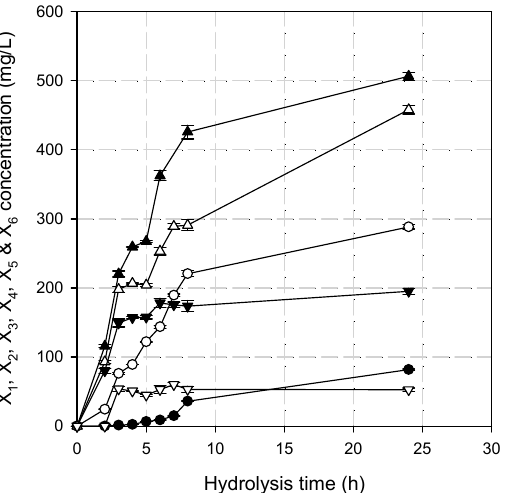
Figure 7. The time course of oat spelt xylan hydrolysis by BsXyn10. Symbols: ( ) X1, ( ) X2, ( ) X3, ( ) X4, ( ) X5 and ( ) X6.